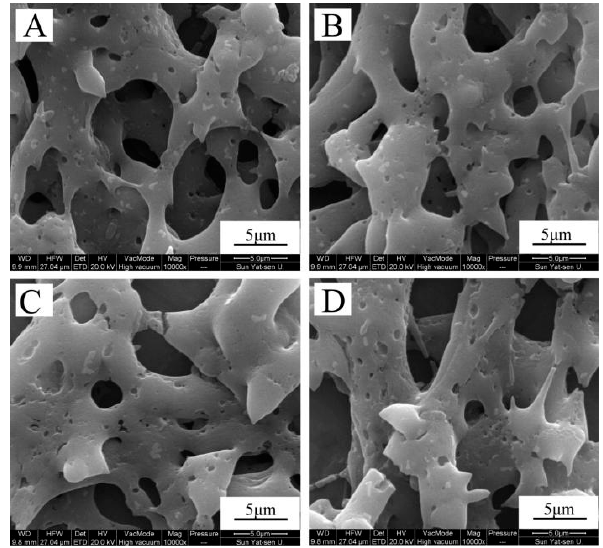
Figure 4. Morphological changes in zein ( A ); zein/gelatin-1 ( B ); zein/gelatin-2 ( C ); and zein/gelatin-3 ( D ) electrospun nanofibers after enzymatic degradation for 7 days.